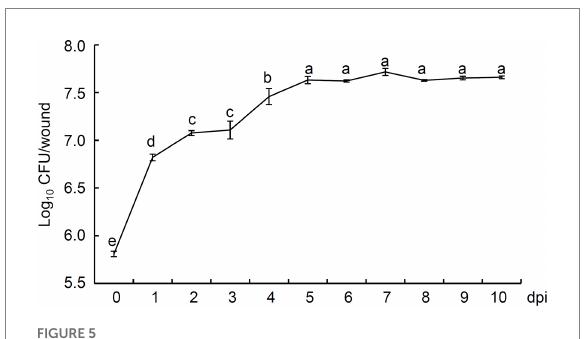
FIGURE 5 Population dynamics of Paenibacillus polymyxa strain Nl4 in wounds of pear twig. Population densities were expressed as Log 10 CFU/wound. Each data represents the mean ± SD of three biological replicates. Different lowercase letters indicate significant differences according to Student’s t -test ( p <